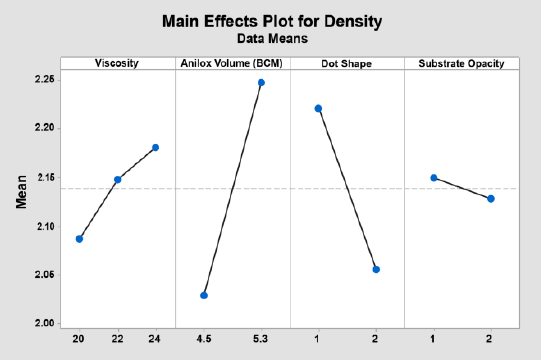
displayed a higher print density than substrate 2 i.e.